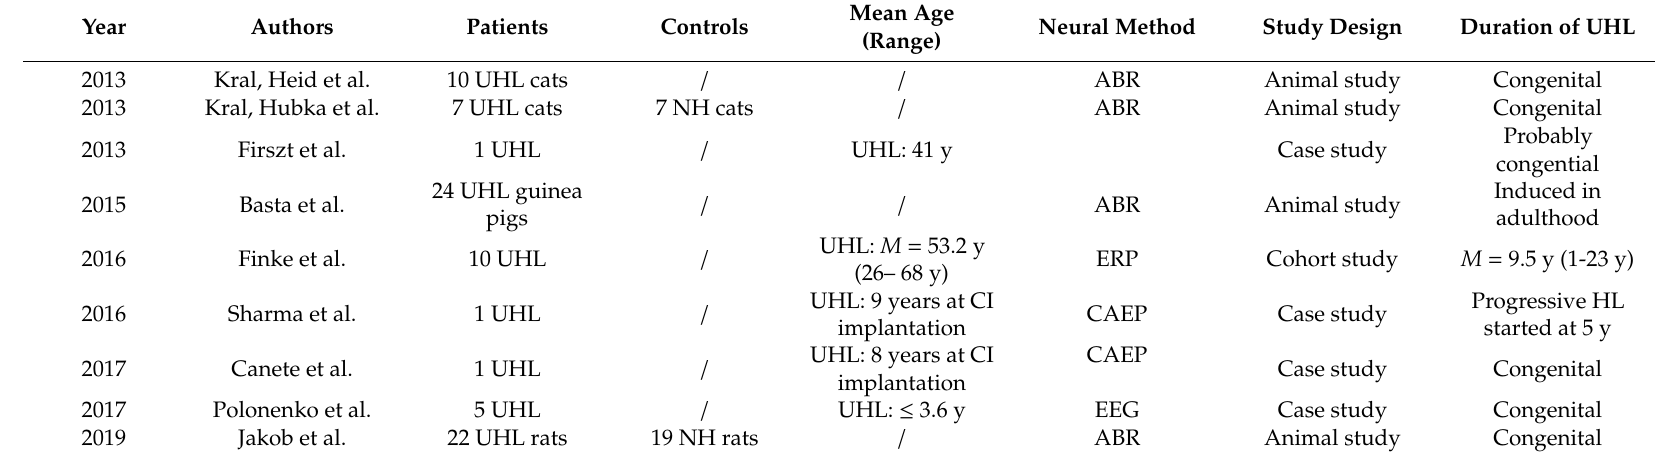
Table 2. List of included articles on monaural hearing